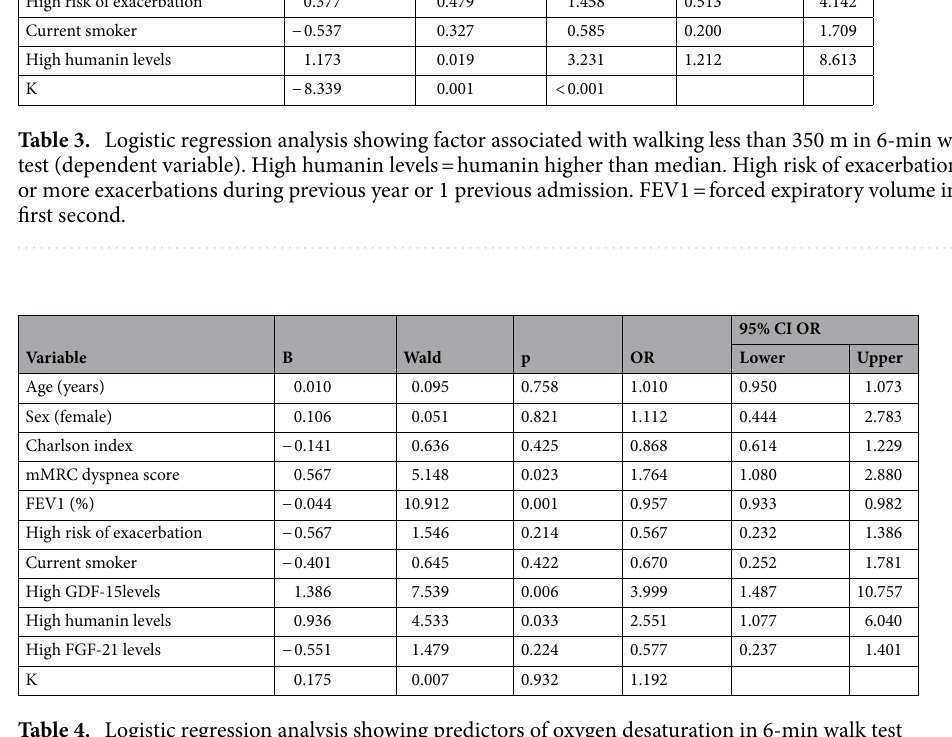
Table 4. Logistic regression analysis showing predictors of oxygen desaturation in 6-min walk test (dependent variable). High GDF-15 levels = GDF-15 higher than the median (> 1244 pg/mL). High humanin levels = humanin higher than median (> 246 pg/mL). High FGF-21 levels = FGF-21 higher than the median (> 321.9 pg/mL). High risk of exacerbation = 2 or more exacerbations during previous year or 1 previous admission. FEV1 = forced expiratory volume in the first second. Oxygen desaturation (OD) was defined as ≥ 4% reduction between pretest and posttest arterial oxygen saturation (Δ SpO 2 ≥ 4%) and posttest SpO 2 < 90% measured by pulse